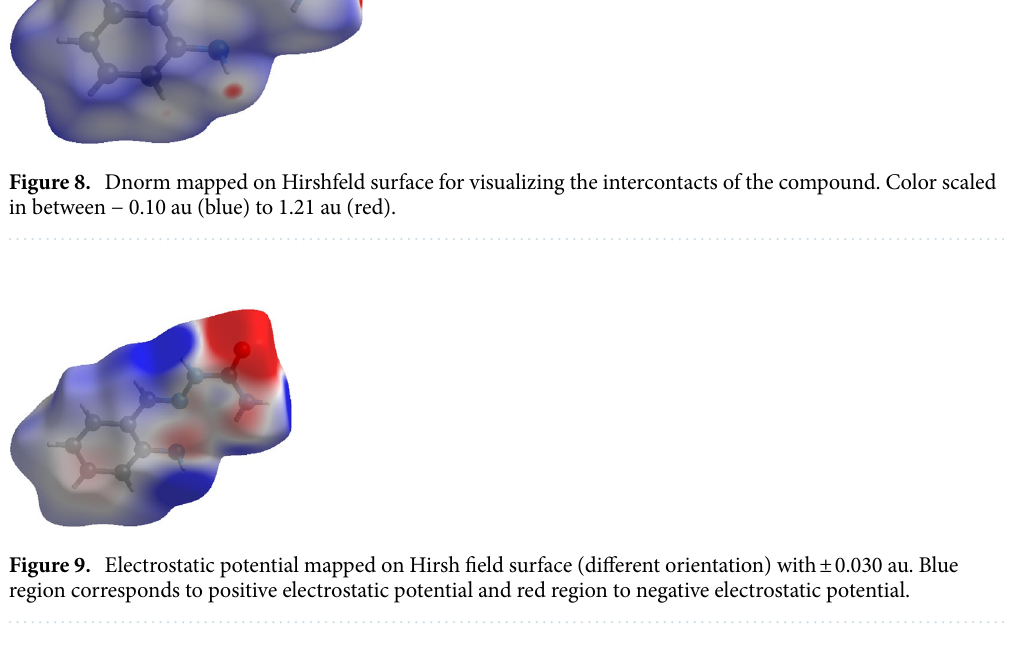
interactions 50 . The strong hydrogen bond spots as dark red region which is the result of short intercontact between the atoms showed on the dnorm surface and light red spots indicated the other intermolecular contact between the atoms. The electrostatic potential range is between plotted in − 0.030 a.u. to + 0.030 a.u on Hir- shfeld surfaces based on Hartree–Fock theory and which is showed electrostatic potential over the Hirshfeld surfaces in Fig. 9 red region (hydrogen acceptor) negative. And blue region (hydrogen donor) positive electro- static potentials 51 . The intercontacts with respect to di and de plotted for 2D fingerprint plots and quantified by using visualization of the Hirshfeld surfaces (Fig. 10). The intercontacts were found to be C…H (13.3%), H…H (47.6%), N…H (4.1%), O…H (9.1%). The intercontacts generated from the 2D Finger print plots are shown in Fig. 10. The major contributions of intercontacts Hirshfeld analysis are from H…H, C…H, O…H and S…H when compared to other intercontacts.